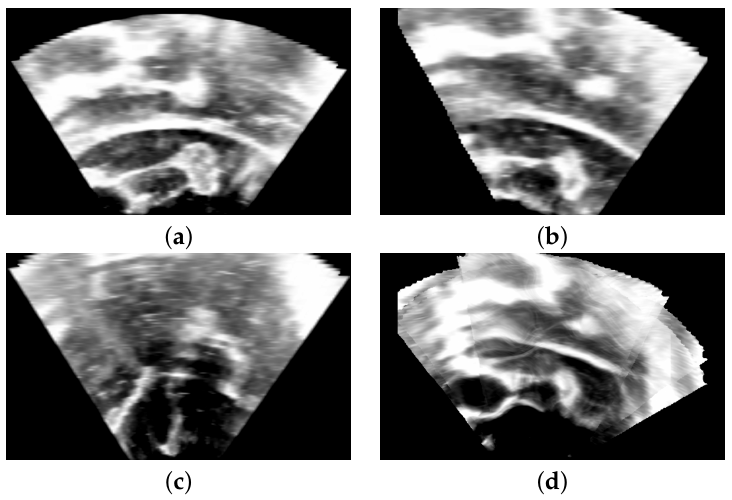
Figure 6. Original volumes simulating transgastric ( a , b ) and mid-esophageal ( c ) views of porcine valve unit. Resulting volume from compounding ( d